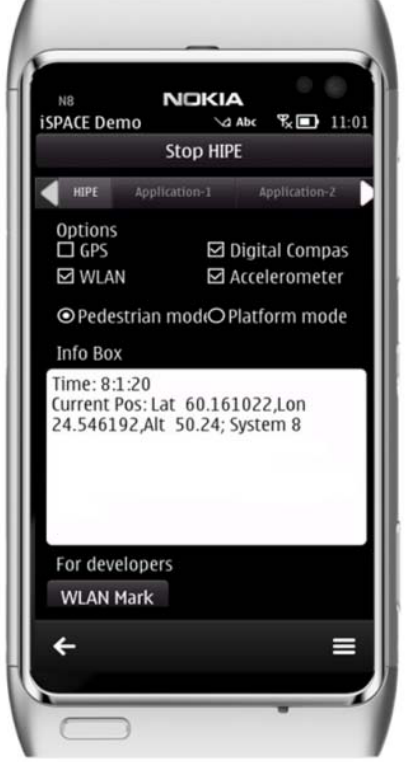
Figure 3. The interface of the HIPE allows developers to select the sensor options. The graphical interface is not required when the engine is embedded into a specific application.